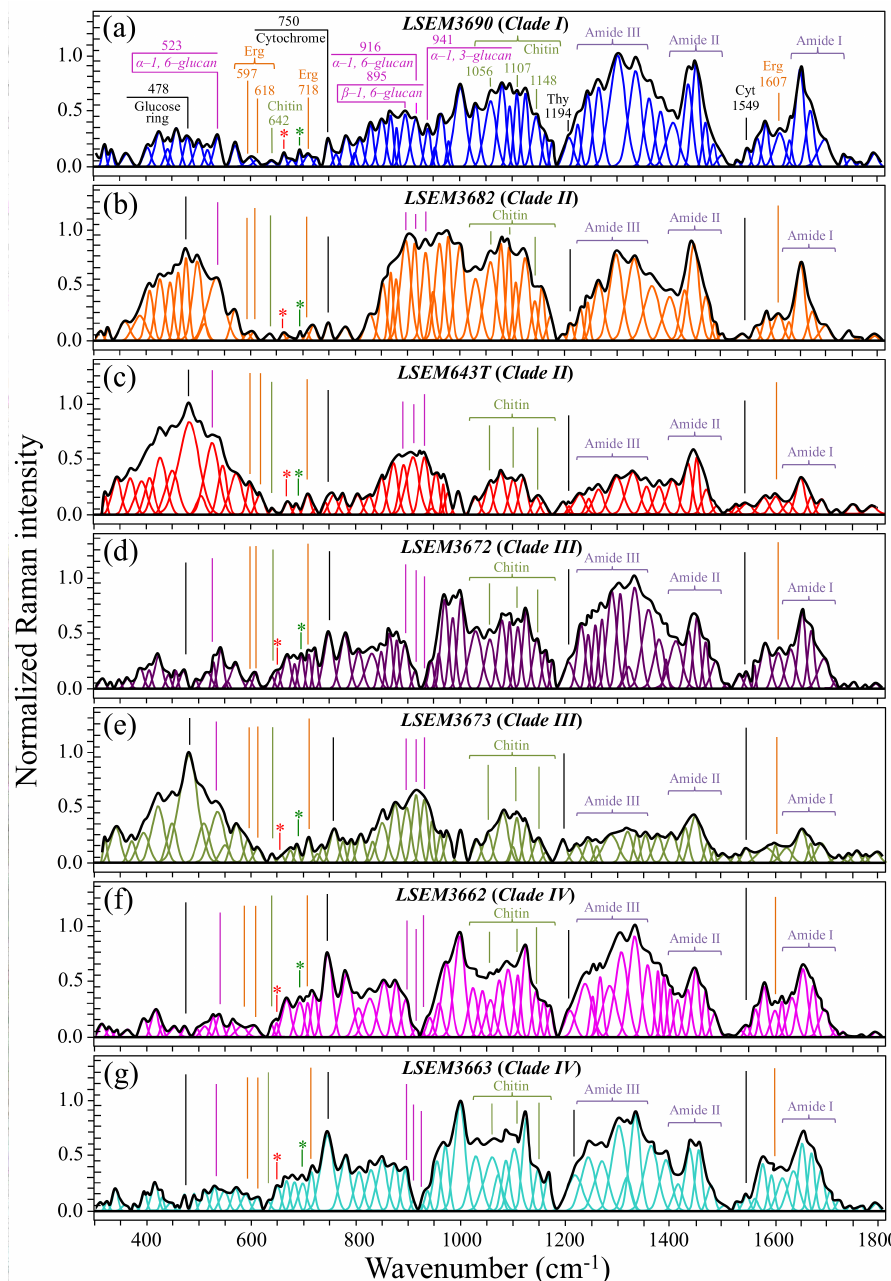
Figure 2. ( a – g ) Deconvoluted Raman spectra for the seven investigated samples of C. auris (cf. labels in inset). Each spectrum represents the average of 20 spectra collected with a 20 × objec- tive lens on each sample at different locations. Band assignments in inset are discussed in text (wavenumbers are in cm − 1 units); red and green asterisks locate signals from ergosteroids and β -chitin allomorph,